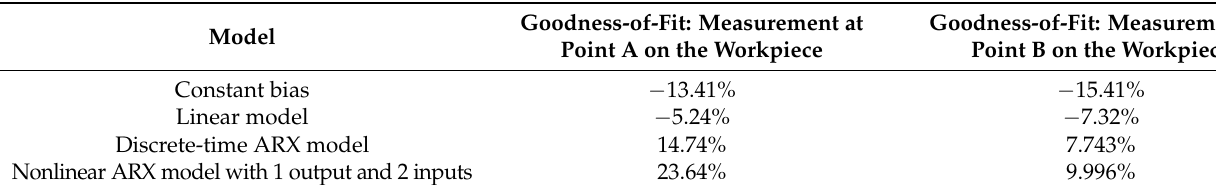
Table 2. Comparison of goodness-of-fit for different models.